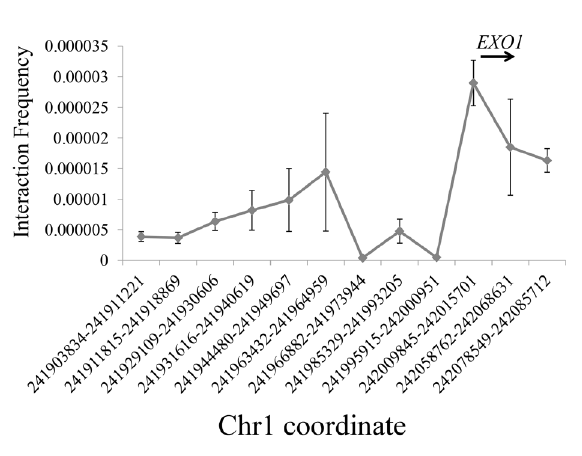
Figure 2 – Interaction efficiency between the enhancer containing rs72755295 and surrounding genome regions in 1q43. The x axis indicates the location of restriction fragments in chr1 (relative to human genome build 37) while the y axis shows the relative interaction efficiency. The above arrow shows the schematic EXO1 position and transcript direction. All data is shown as